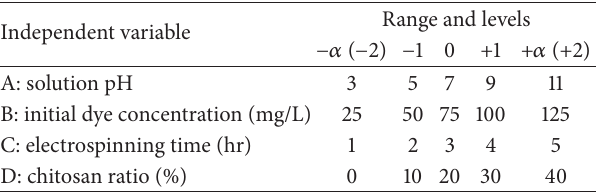
Table 1: Levels of different independent variables in coded and actual